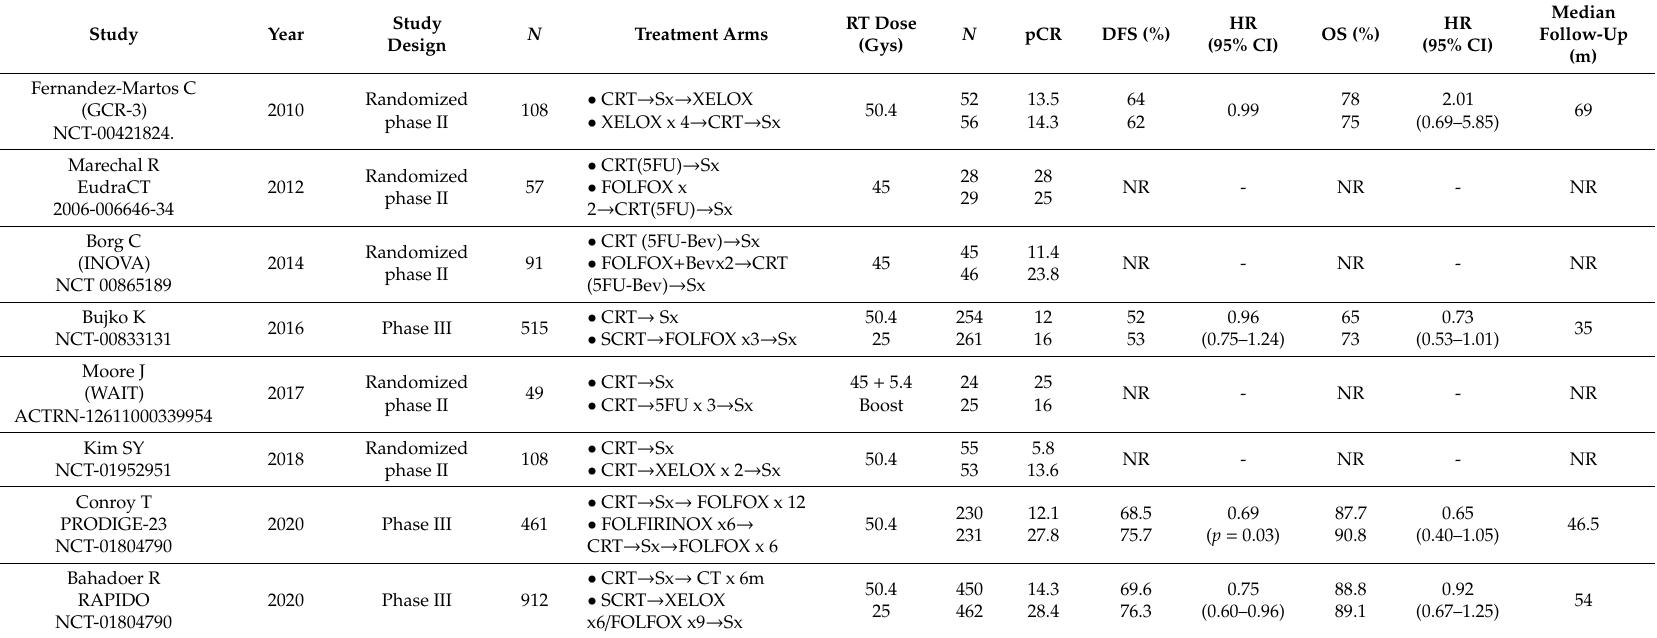
Table 1. Main characteristics of randomized controlled trials